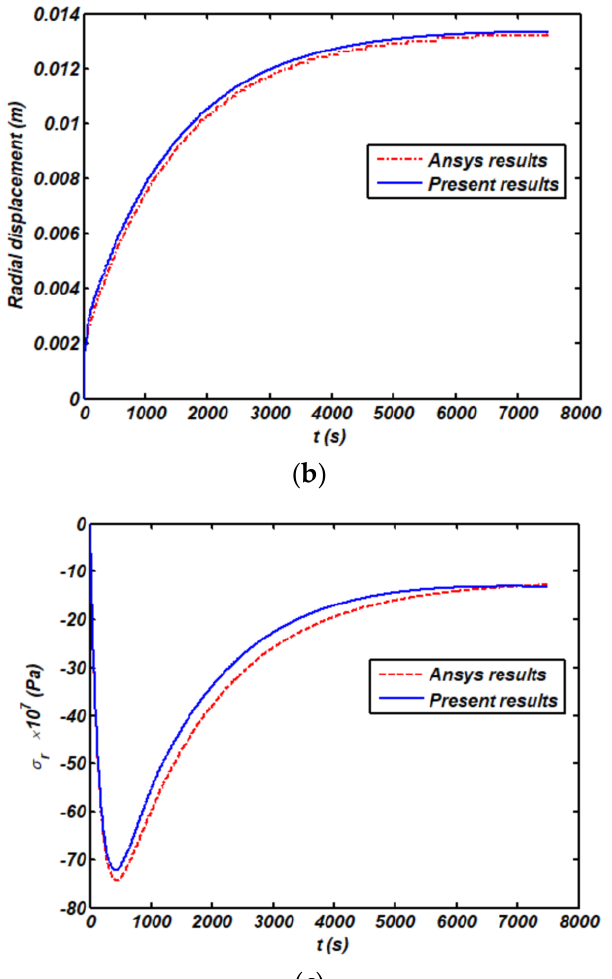
Figure 2. Time history of temperature ( a ), radial displacement ( b ), and radial stress ( c ) for a center point of cone compared with ANSYS Workbench.